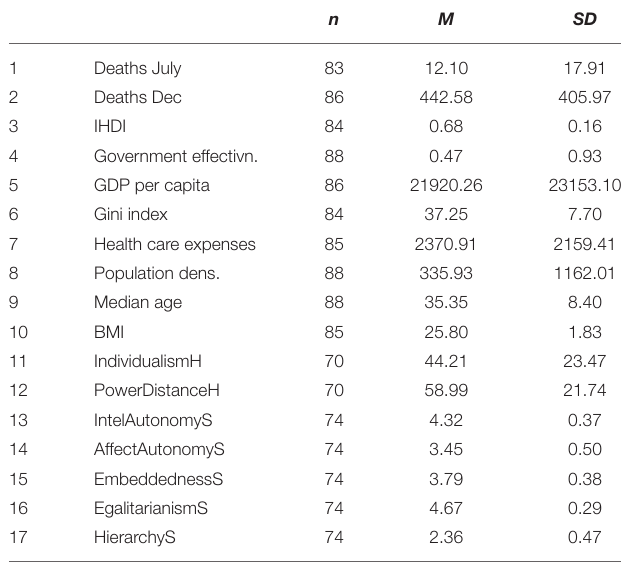
TABLE 2 | Descriptive statistics for all